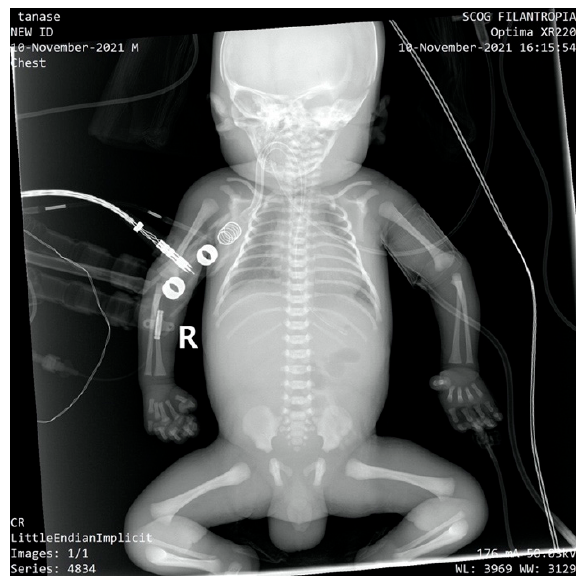
Figure 2. Thoraco-abdominal X-ray-poor aeration of the colic frame, ascites fluid. The newborn exhibited hepatomegaly with the right lobe extending caudally. En- larged hepatic vein and associated splenomegaly were observed on abdominal ultra- sound. A cardiac ultrasound revealed mild pulmonary hypertension, mild sized patent ductus arteriosus with left to right shunt, patent foramen ovale with left to right shunt, representing mild cardiac involvement which responded accordingly to the inotrope and vasopressors